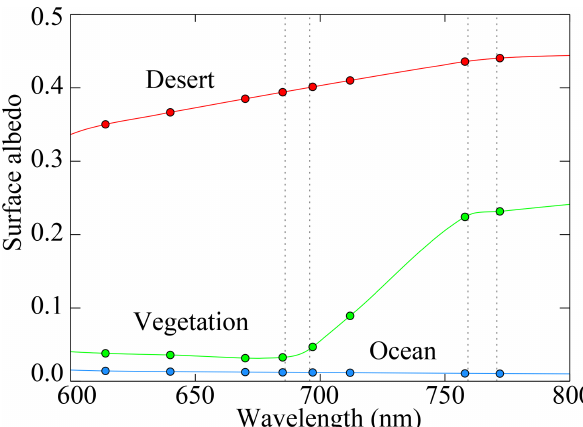
Figure 2. Mean surface albedo over 1 month (August) and for dif- ferent surface types as a function of wavelength. “Desert” stands for the Sahara, “Ocean” for the Atlantic Ocean and “Vegetation” for the Amazon rainforest. The vertical dashed lines indicate the lo- cation of the oxygen A band (around 761nm) and B band (around 687nm). The values come from the SCIAMACHY surface albedo database described in Tilstra et al.